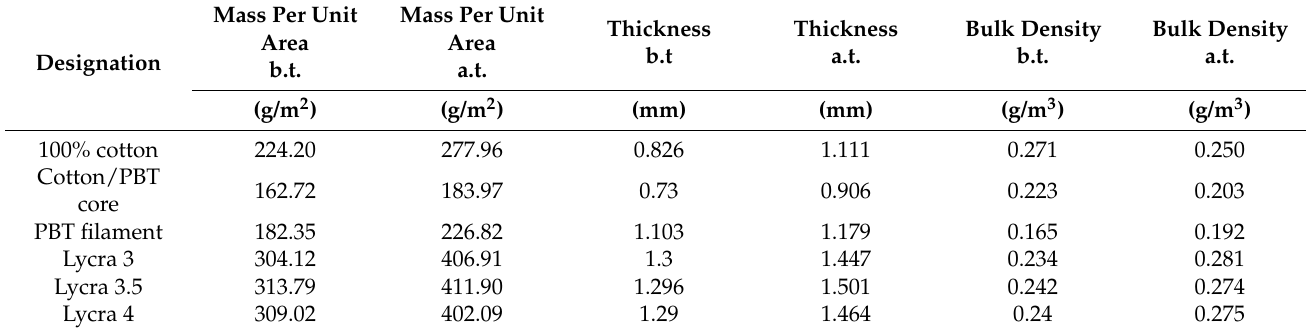
Table A4. Selected physical properties of samples before treatment (b.t.) and after treatment (a.t.).